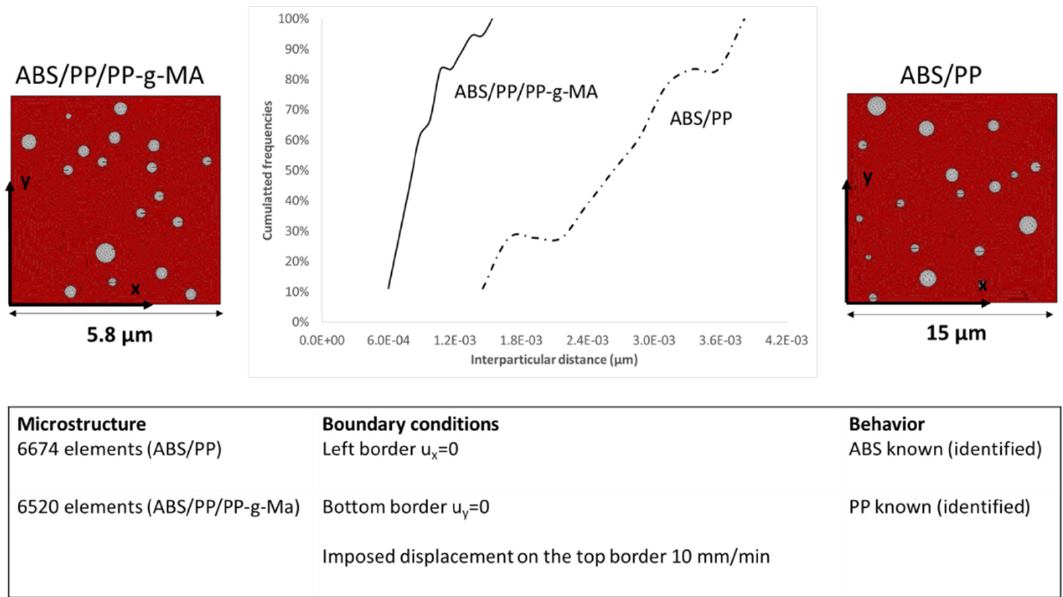
Figure 16. Finite element modelling of ABS and PP blend: structure and boundary conditions.